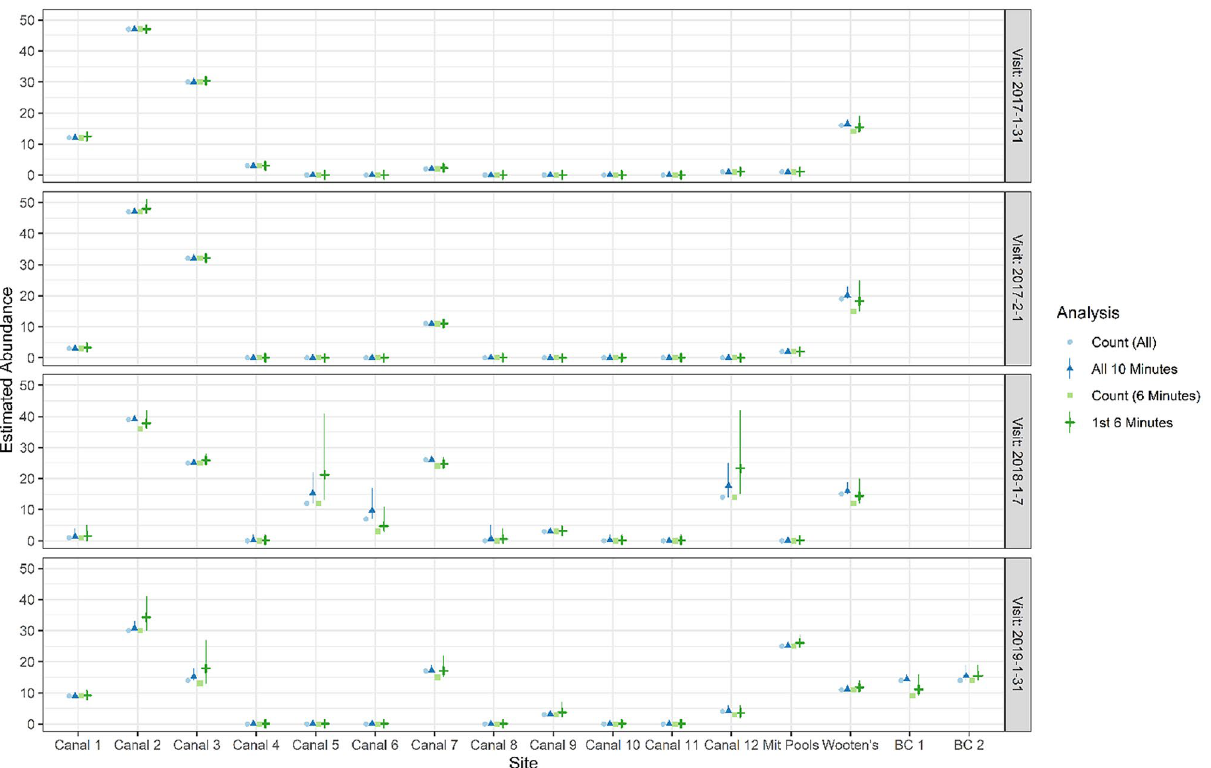
Figure 7. Estimates of abundance (triangles and crosses) and maximum counts (circles and squares) by site and visit for 6 and 10 min of video. Symbols indicate means (point estimates) and lines 95% credible intervals. Site “Mit Pools” are the mitigation pools and “BC” indicates Big